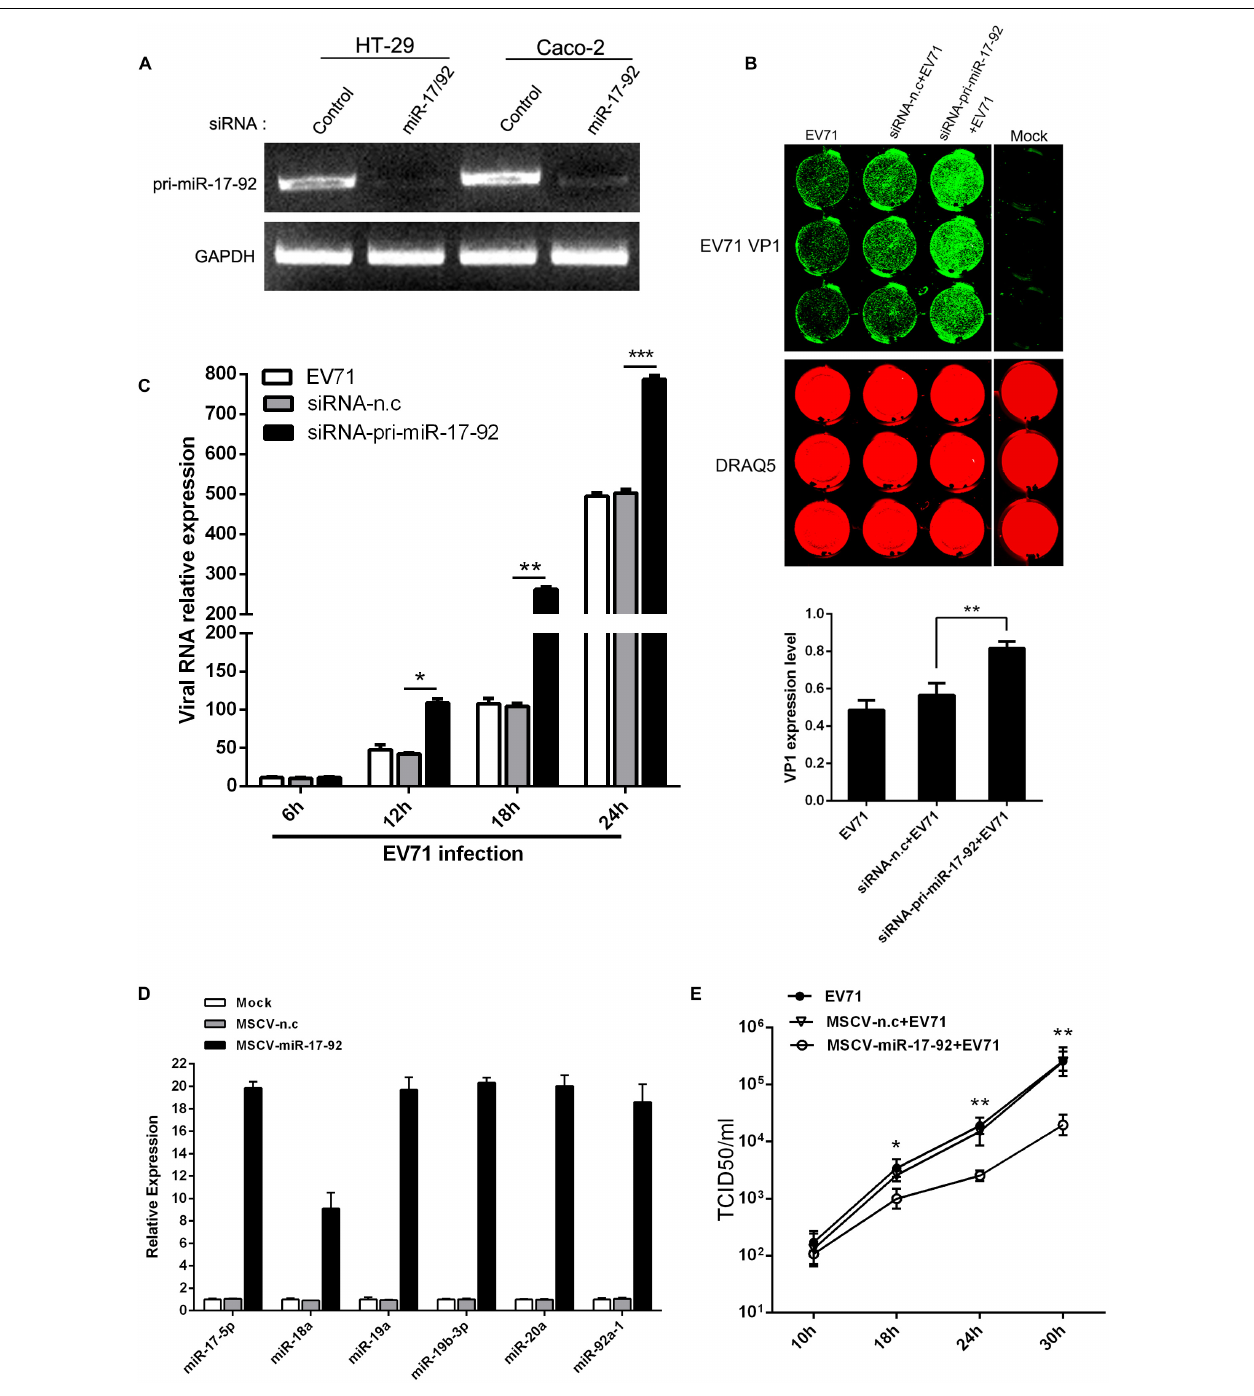
FIGURE 2 | The expression level of miR-17-92 cluster affected EV71 replication. (A) RT-PCR analysis of pri-miR-17-92 cluster expression after HT-29 or Caco-2 cells were transfected with si-pri-mir-17-92 for 48 h. (B, C) HT-29 cells were infected with EV71 (MOI = 1) prior to being transfected with si-pri-mir-17-92 for 24 h. EV71 VP1 expression level was determined via In-cell Western and normalized by DRAQ5 (B) , and viral RNA level was quantified via real-time quantitative PCR at indicated time points normalized against GAPDH transcript level (C) . (D) Quantitative real-time-PCR analysis of miR-17-92 component expression in HT-29 cells when the cells were transfected with MSCV-miR-17-92 vector or negative control (MSCV-n.c) for 48 h. (E) Titers of progeny EV71 in the culture supernatant of infected-cells before the cells were transfected with MSCV-miR-17-92 vector or negative control. All experiments were performed three times and the representative results were shown. The data were presented as mean ± SEM ( ∗ P < 0.05, ∗∗ P < 0.01, ∗∗∗ P < 0.001).